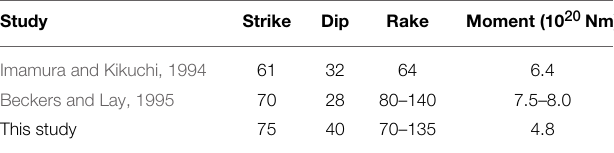
TABLE 2 | Comparison of fault parameters for the 1992 Flores